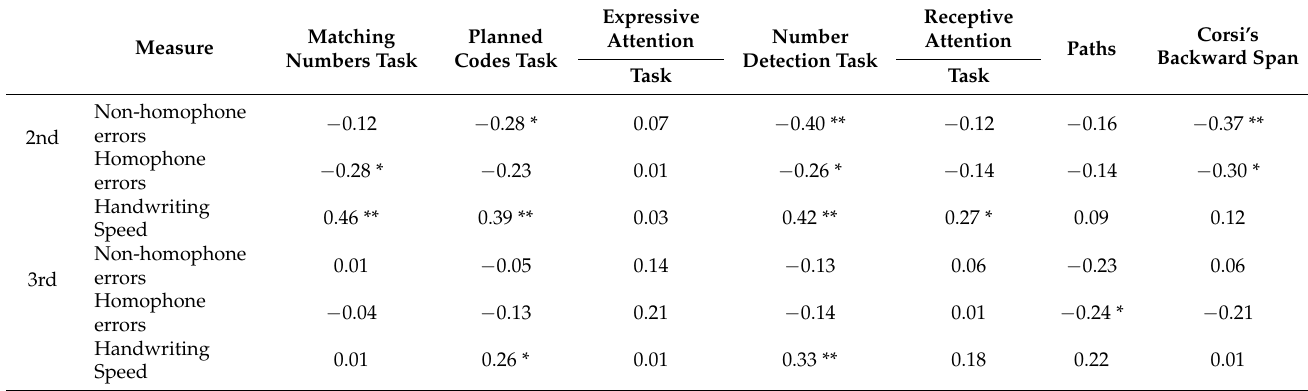
Table 3. Correlation analyses between all measures regarding spelling accuracy, attention, and visuo-spatial working memory skill variables in 2nd grade ( N = 59) and 3rd grade ( N = 53) children (first data collection): Pearson’s linear correlation